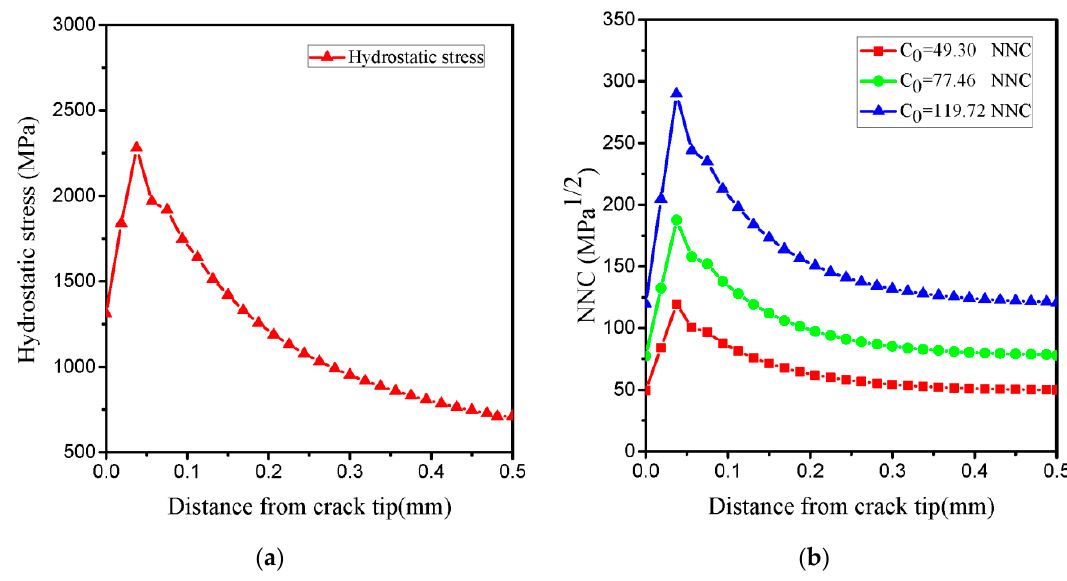
Figure 11. ( a ) Calculated hydrostatic stress distribution as a function of the distance from the crack tip; ( b ) calculated normalized hydrogen concentration NNC distribution as a function of the distance from the crack tip for C L 0 (49.30, 77.46 and 119.72 NNC). NNC: normalized hydrogen concentration.